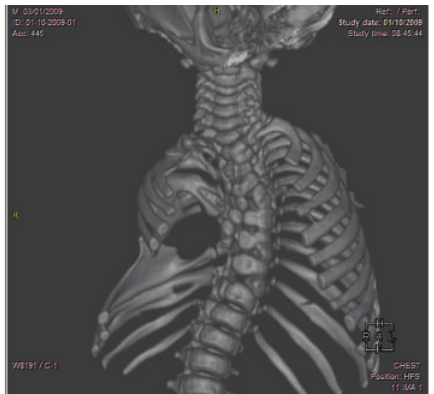
Figure 3: Three-dimensional CT scan AP thoracic image revealing full details of block, fused, and hemivertebrae as well as misaligned, absent, fused, and hypoplastic ribs at the right side and supernumer- ary ribs at the opposite side.